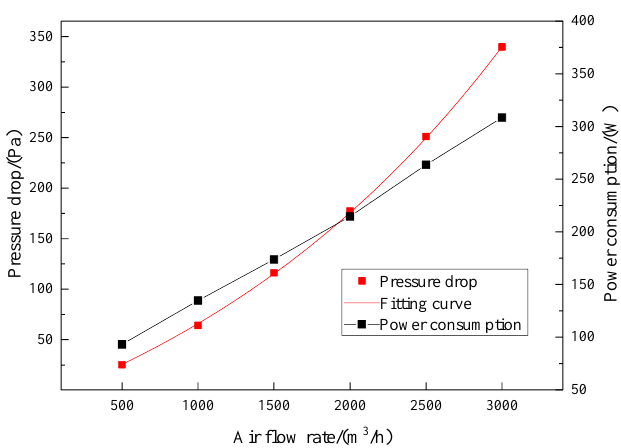
Figure 19. Pressure drop and power consumption of air side.